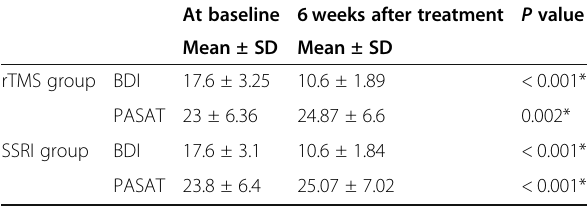
Table 4 BDI and PASAT scores before and after receiving rTMS and